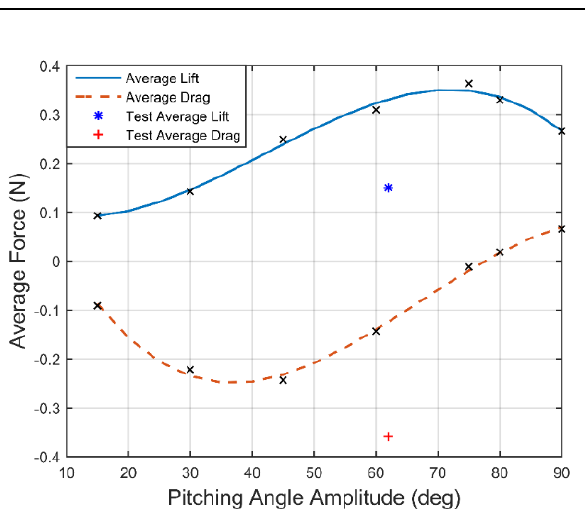
Figure 17. Average lift and drag forces of the wing in a range of pitching amplitude 15°~90°.